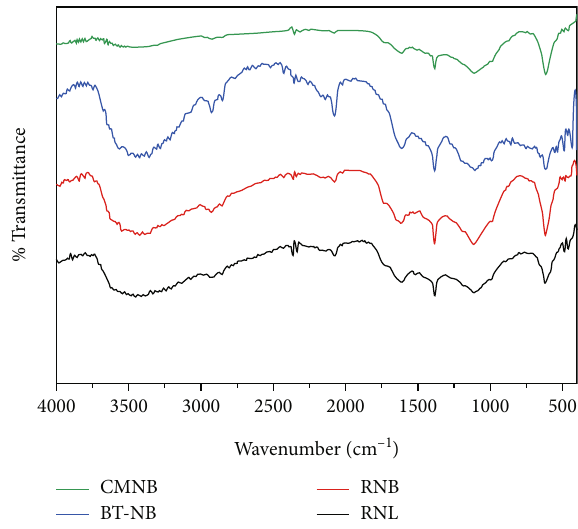
Figure 5: Fourier transformation infrared (FTIR) spectrum for raw neem bark (RNB), raw neem leaf (RNL), base treated neem biomass (BT-NB), and chemically modi fi ed neem biomass